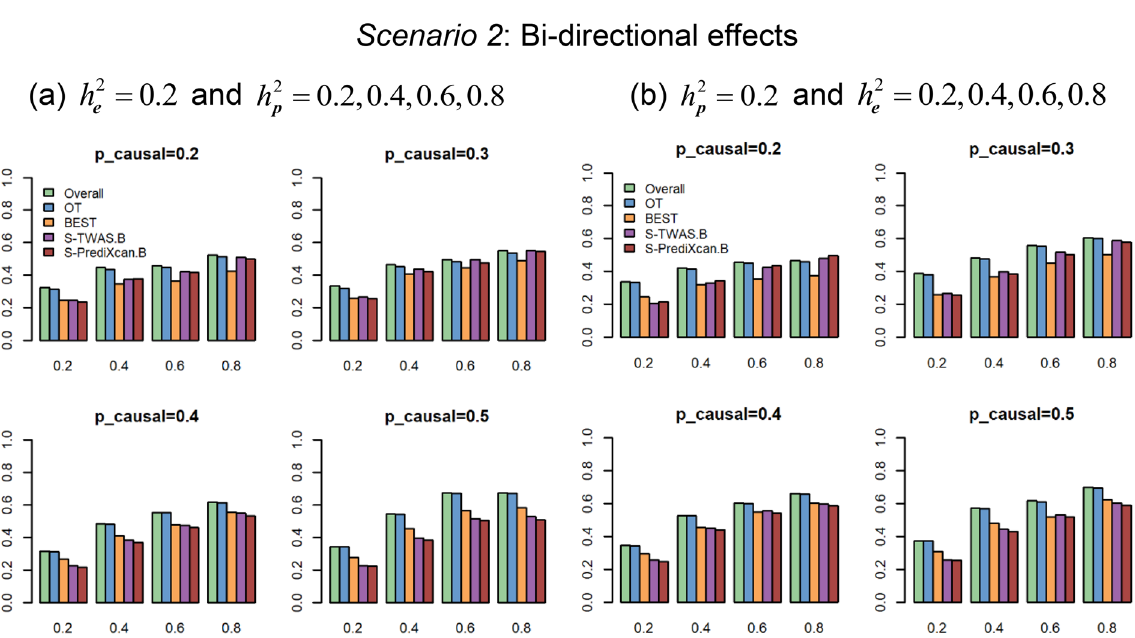
Figure 2. Power comparisons of gene-based association tests at 1.75 × 10 − 6 significance level under Bi-directional effects ( β 1 = β 2 = − β 3 = − β 4 ) with p causal = ( 0.2, 0.3, 0.4, 0.5 ) based on gene AGTRAP . ( a ) Estimated power against phenotypic heritability h 2 p with expression heritability h 2 e = 0.2 ; ( b ) Estimated power against expression heritability h 2 e with phenotypic heritability h 2 p = 0.2